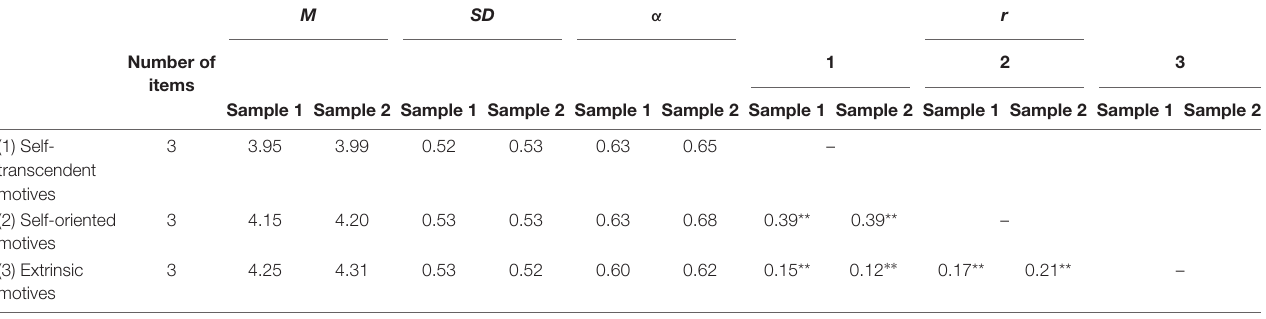
TABLE 2 | Descriptive statistics, Cronbach’s alpha coefficients, and intercorrelations. M SD